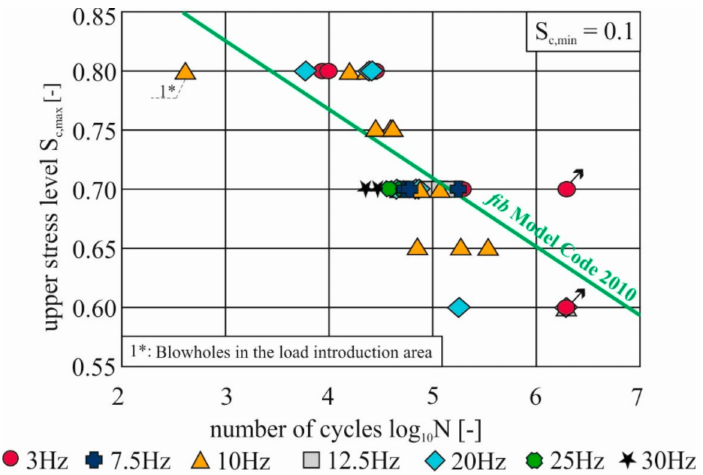
Figure 2. Achieved numbers of load cycles at different maximum stress levels and load